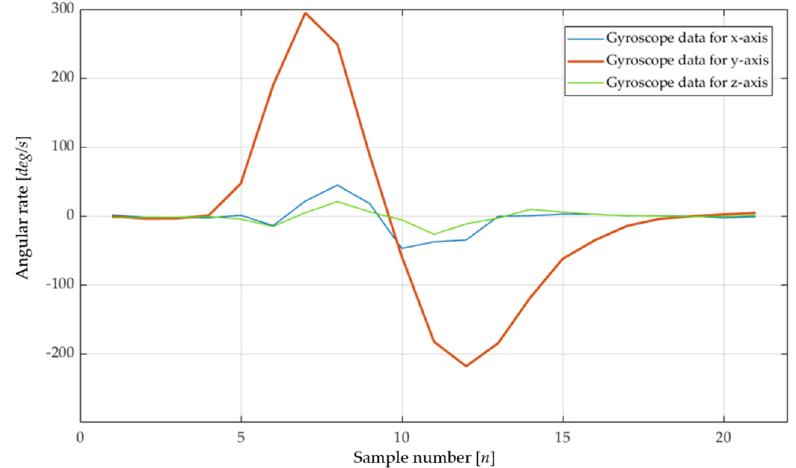
Figure 3. Experimented reference waveform patterns of the “Down” gesture having different magnitudes.